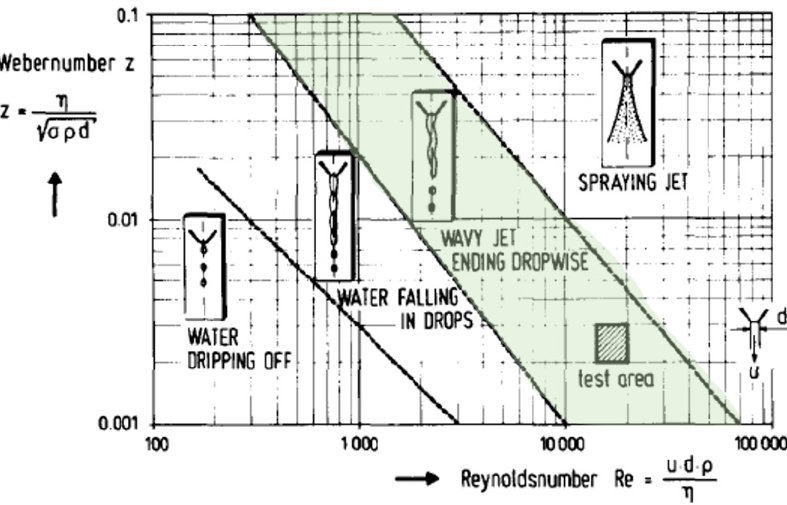
Figure 24. Modes of decomposition of water jets in atmosphere [86].